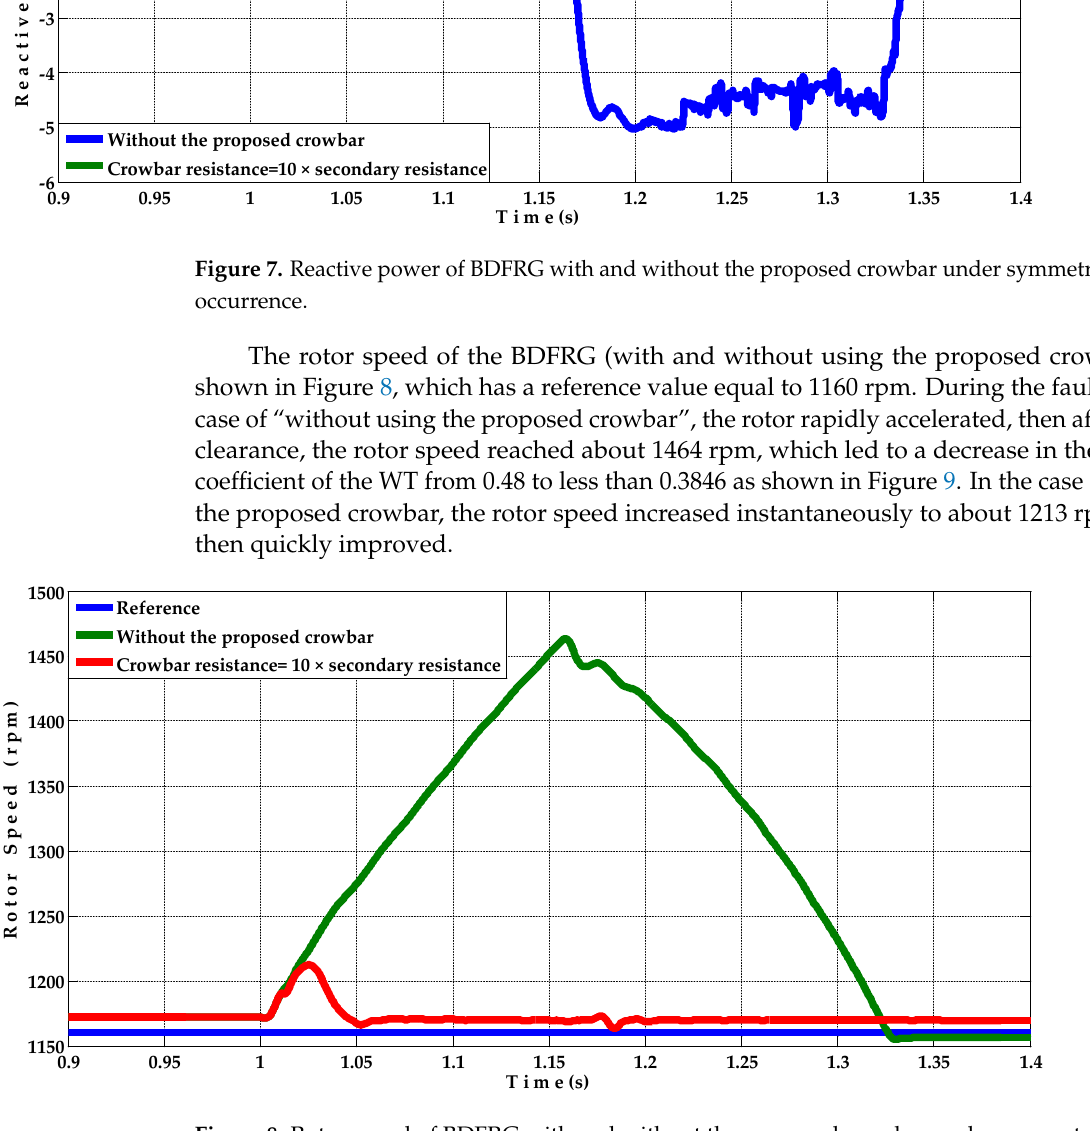
Figure 9. Power coefficient of wind turbine with and without the proposed crowbar under symmet- rical fault occurrence. The primary and secondary currents of the BDFRG (without and with using the pro- posed crowbar) are shown in Figures 10 and 11 in the same order. In the case of “without using the proposed crowbar”, during the fault, both currents were increased for a certain